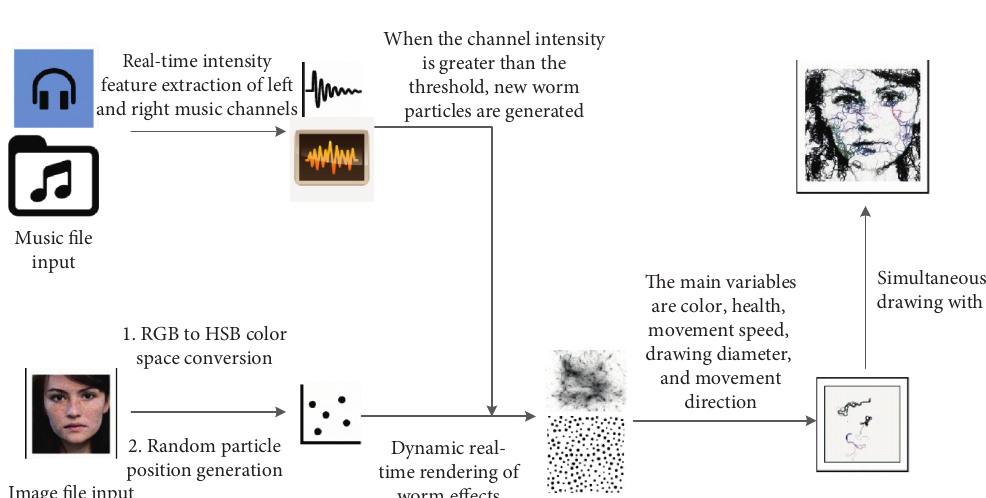
Figure 8: Image style migration operation process guided by music